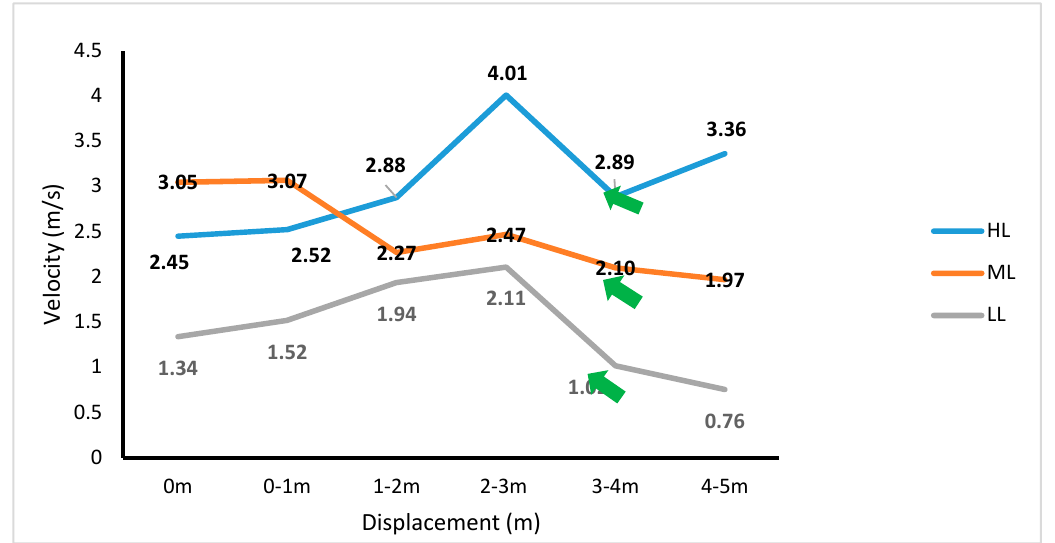
Figure 3. Horizontal velocity of each athlete, recorded during a double salchow